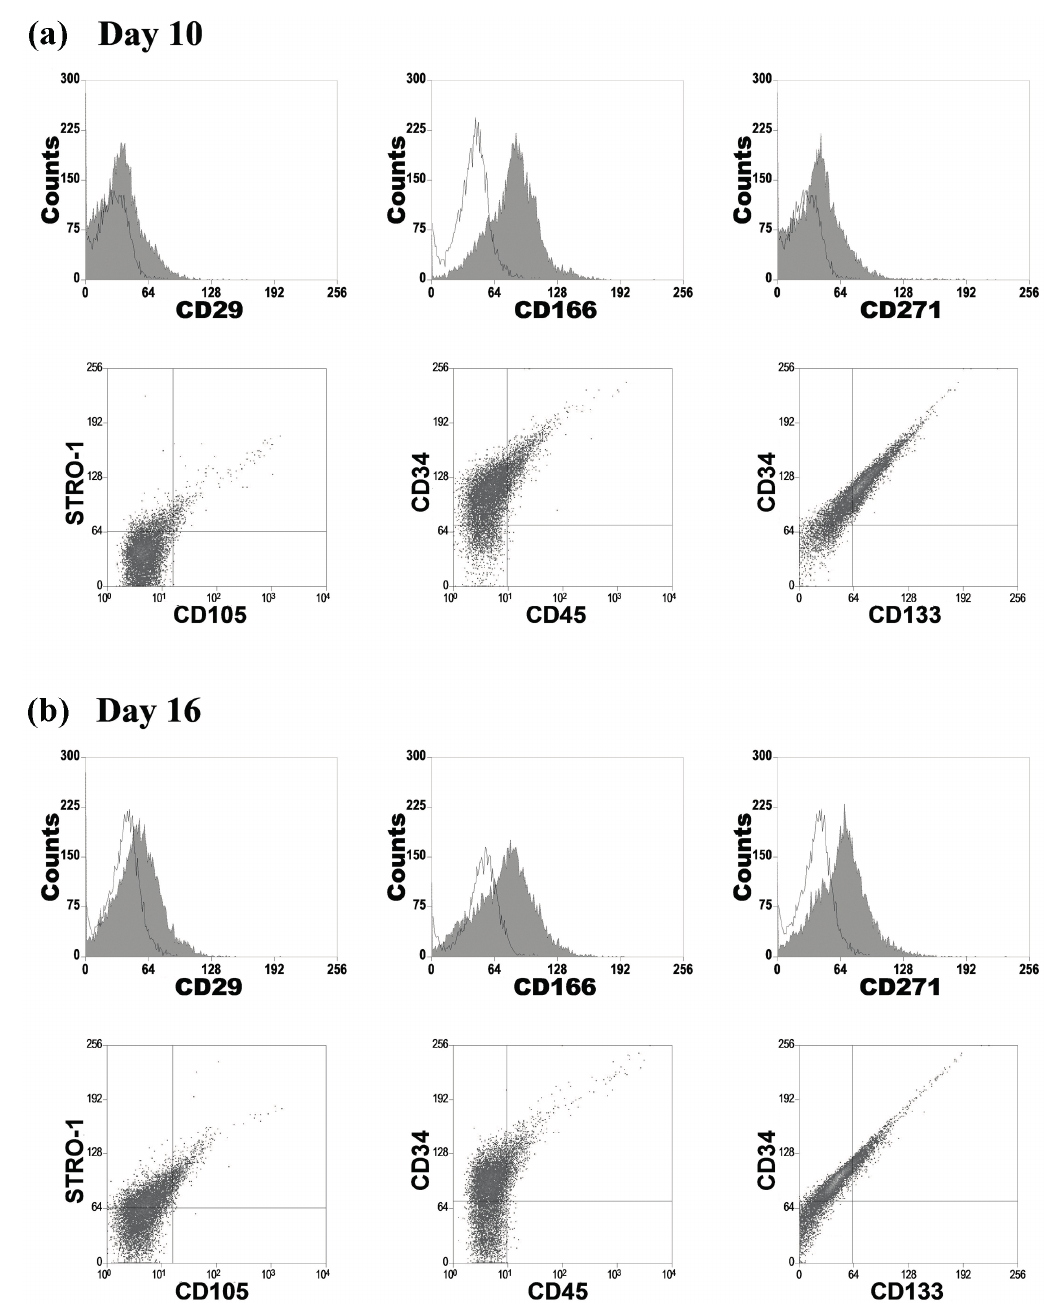
Figure 3. Immunophenotype profiles of 3D culture cells for hematopoietic, mesenchymal and endothelial markers. Representative FACS (fluorescence-activated cell sorting) analysis at days 10 ( a ) and 16 ( b